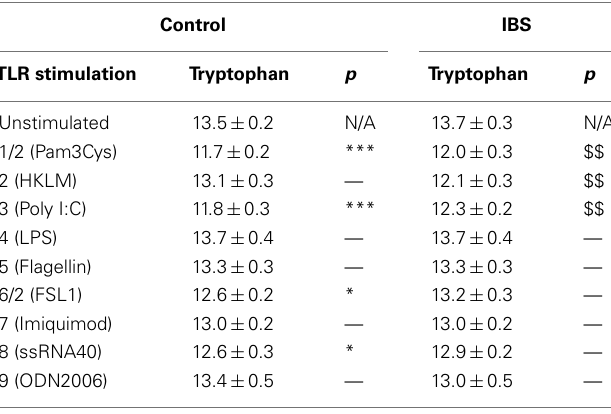
Data are expressed as means ± SEM. Statistical differences between stimu- lated and unstimulated groups were determined using Bonferroni post hoc